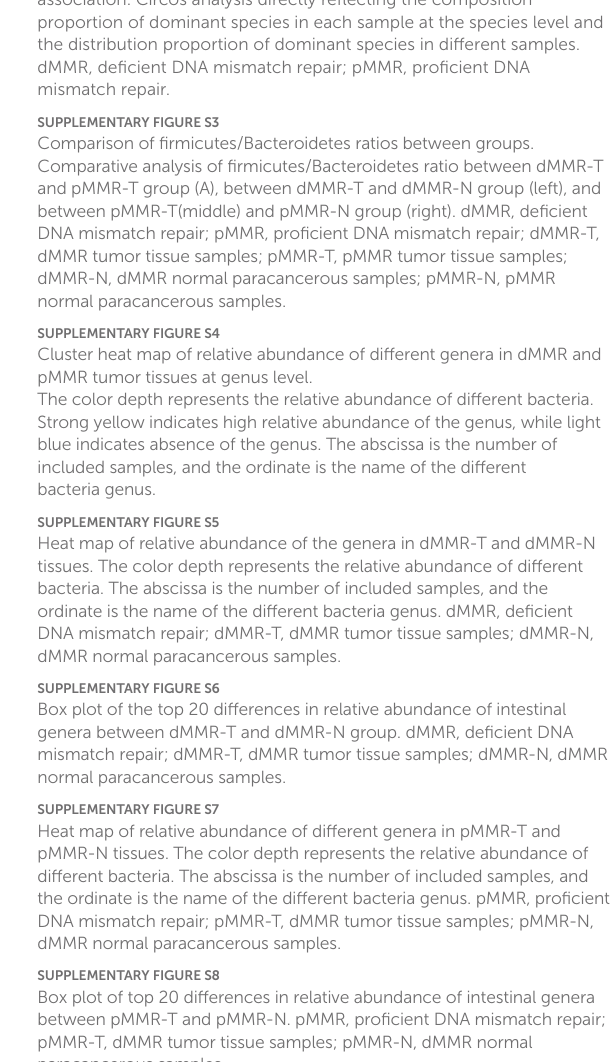
SUPPLEMENTARY FIGURE S1 Weighted and unweighted UniFrac distance PCoA plots of changes in microbiome composition between dMMR and pMMR tumors and their noraml paracancerpus tissues. (A,B) Unweighted (A) and weighted (B) UniFrac distance PCoA diagram of dMMR-T and pMMR-T group; (C,D) WEIGHTED (C) and unweighted (D) UniFrac distance PCoA diagram of dMMR-T and dMMR-N group; (E,F) UNweighted (E) and weighted (F) UniFrac distance PCoA diagram of pMMR-T and pMMR-N group. Each dot represents a sample, and dots with different colors belong to different sample groups. The percentage of the three-dimensional coordinate axis represents the percentage of variance in the original data that can be explained by the corresponding principal coordinate. dMMR, deficient DNA mismatch repair; pMMR, proficient DNA mismatch repair; dMMR-T, dMMR tumor tissue samples; pMMR-T, pMMR tumor tissue samples; dMMR-N, dMMR normal paracancerous samples; pMMR-N, pMMR normal paracancerous samples.